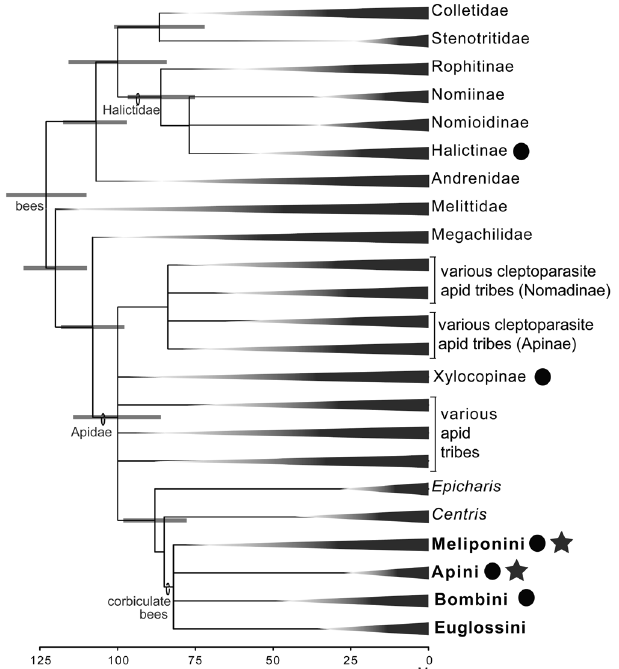
Fig 1. Phylogenetic relationships within bees (Hymenoptera: Apoidea: Anthophila). The overall relationships depicted are those summarized by Danforth et al. (2013). Bee lineages are represented at family-level resolution for taxa not comprising eusocial representatives, or in more detail in cases where eusocial species are present (indicated by solid circles, stars indicate the bee taxa considered obligate eusocial) — see Michener (2007) and Schwarz et al. (2007) for details. Unresolved nodes (i.e., polytomies) and gray shaded branches indicate regions of the tree of bees upon which uncertainty and conflicts have been most noticeable in studies published during the last decade. Branch lengths are proportional to the evolutionary time, and a ruler scaled in million years before the present is given beneath the tree (divergence ages and the estimates for clade ages were taken primarily from Cardinal & Danforth [2013], and complemented by estimates by Brady et al. [2006b], Cardinal et al. [2010], Almeida et al. [2012], Gibbs et al. [2012], and Martins et al.